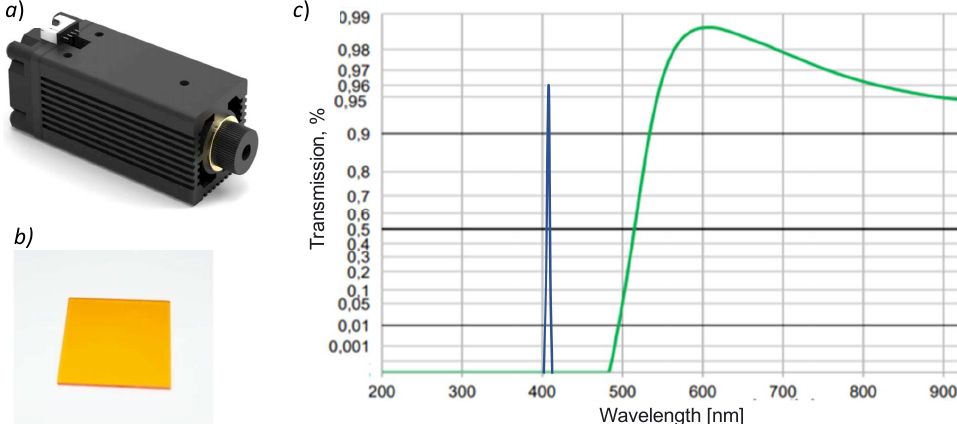
Figure 2. ( a ) The 405nm laser module, ( b ) the longpass OG515 filter, and ( c ) the transmission spectra of the OG515 filter in green and the emission peak of the 405nm laser module in